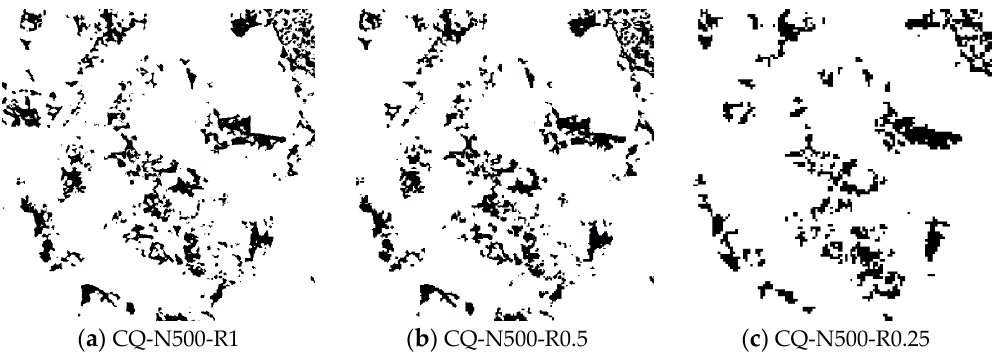
Figure 4. 2D slice of Changqing sample after coarsening operation.